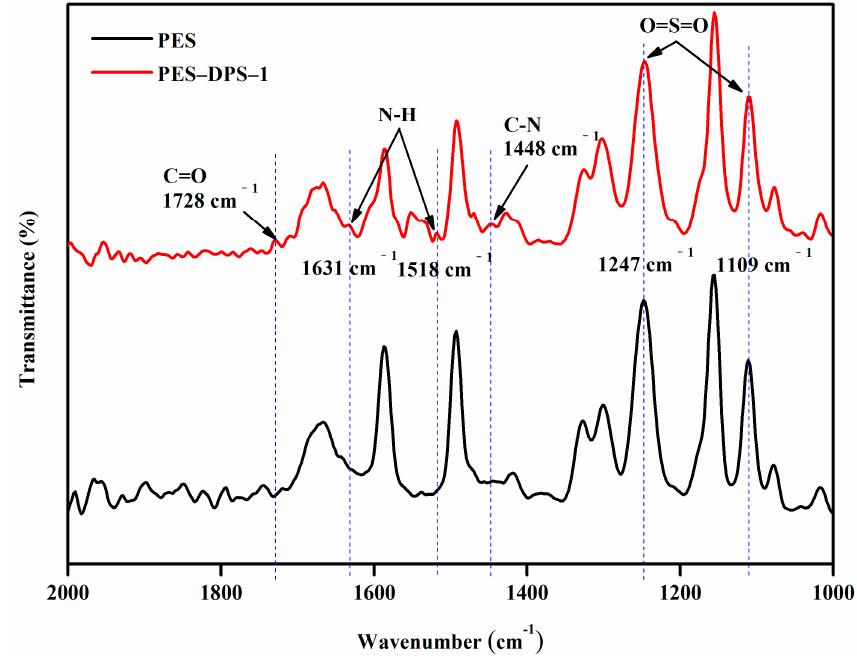
Figure 5. ATR-FTIR spectra of PES and PES–DPS–1 membranes (Blue dashed lines are intended to help locate the corresponding absorption peak).